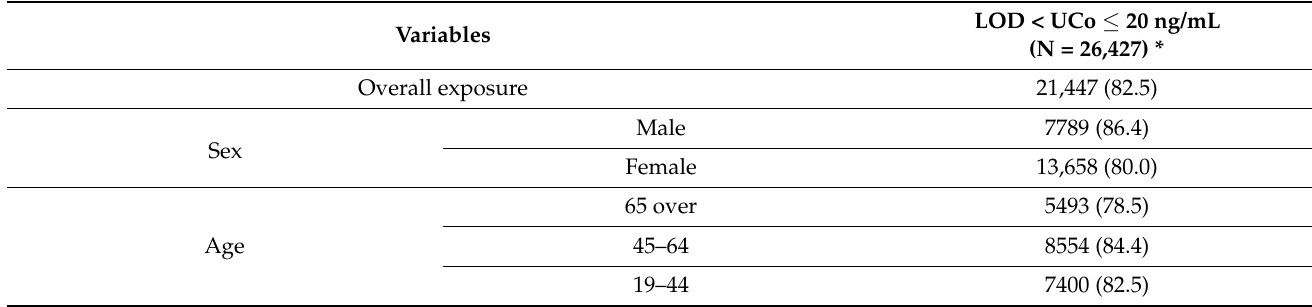
Table 3. SHS exposure rate in nonsmokers with identified cotinine levels (unit: number and weighted